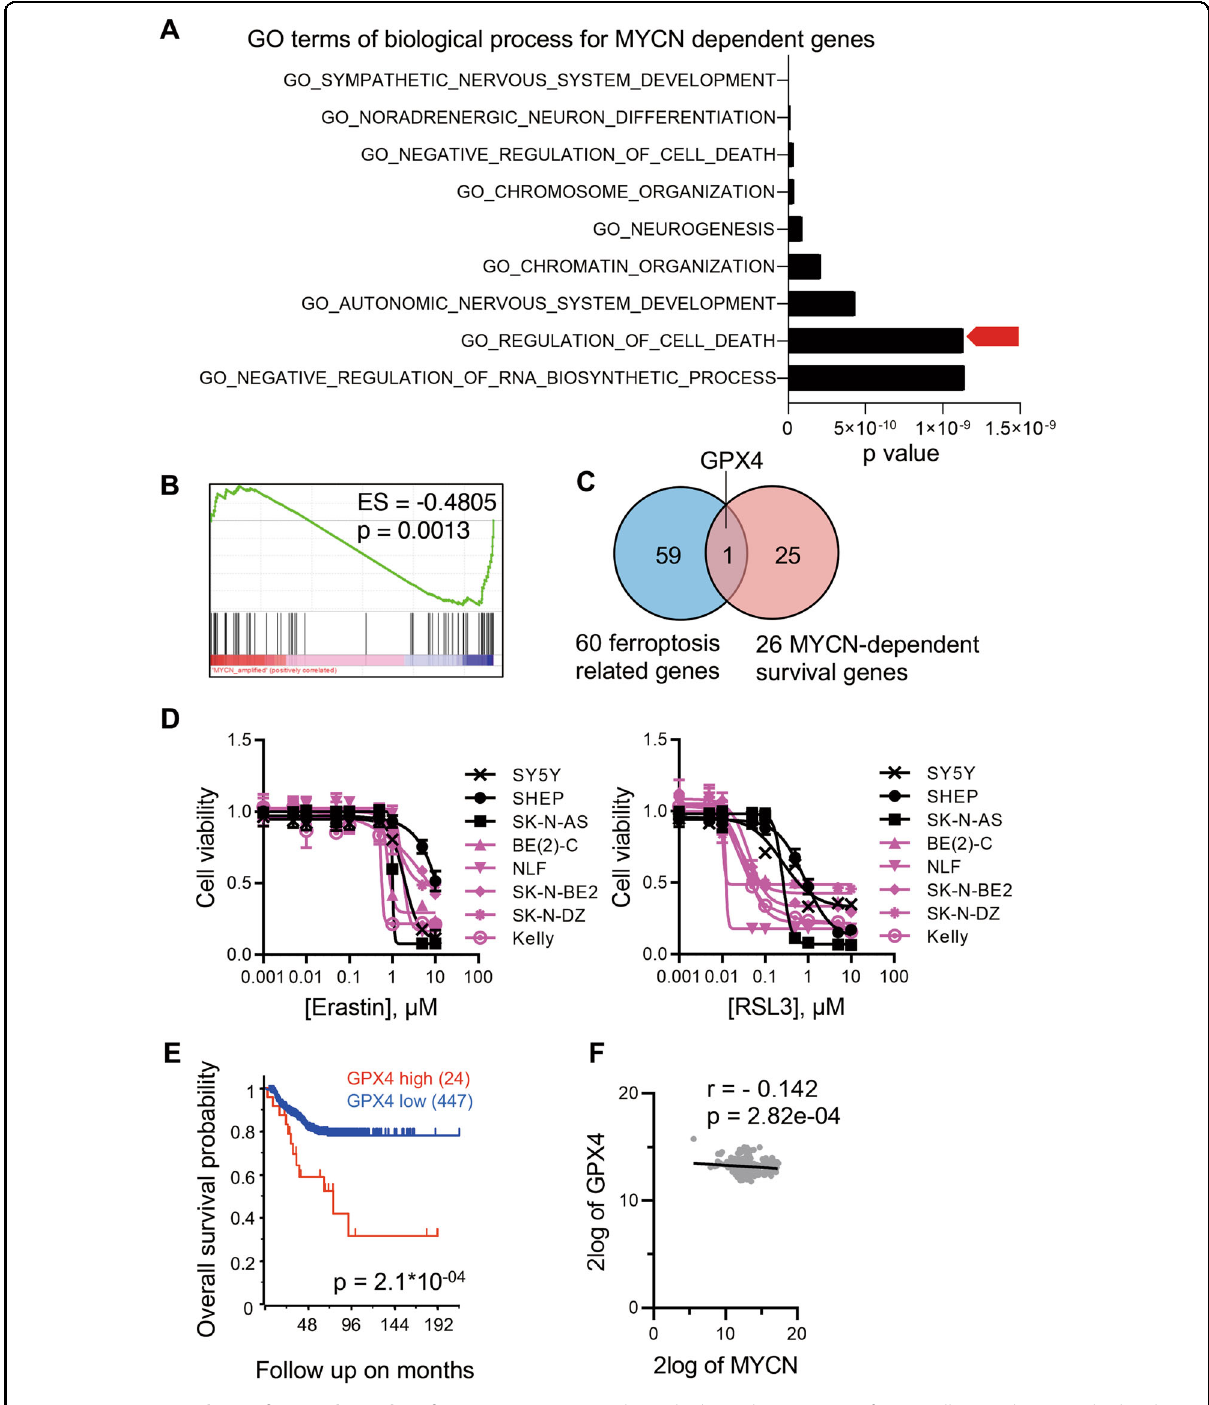
Fig. 1 MYCN is a regulator of GPX4-dependent ferroptosis. A Genes selectively dependent on MYCN for NB cell survival are enriched within a variety of GO terms of biological processes, and the top nine processes are shown according to p values. B GSEA assays of ferroptosis-related genes showing enrichment with MYCN ampli fi cation based on RNA-seq data of six human NB cell lines. ES, enrichment score. C GPX4 is shared between ferroptosis-related and MYCN-dependent survival genes. D Cell viabilities when different concentrations of the GPX4 inhibitor (1S, 3R)-RSL3 (RSL3) and system X c ( − ) inhibitor Erastin were used as ferroptosis inducers in multiple human NB cell lines ( MYCN ampli fi ed SK-N-BE2, BE(2)-C, NLF, SK-N-DZ, and Kelly are represented in pink; and MYCN non-ampli fi ed SHEP, SK-N-AS, and SY5Y are shown in black; n = 4). E Kaplan – Meier survival curves for NB patients based on GPX4 mRNA expression. Gene expression and clinical data were retrieved from GSE45547. F Correlation analysis between GPX4 and MYCN expression based on the data retrieved from GSE45547. * p < 0.05, ** p < 0.01.